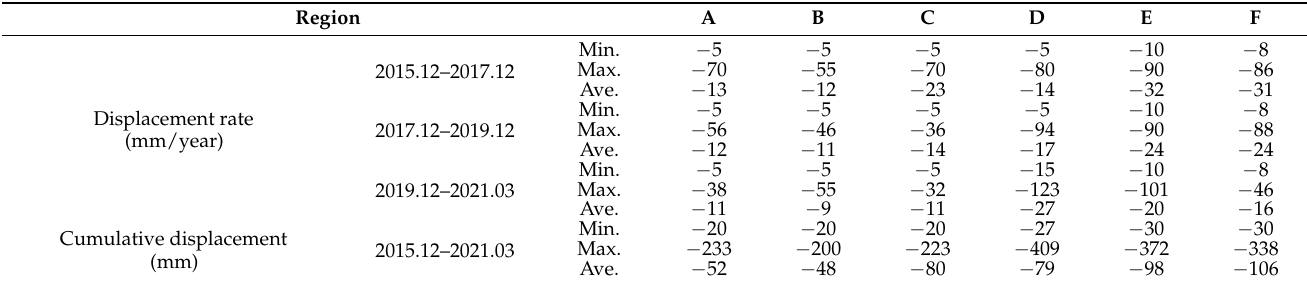
Table 2. Statistics of the surface displacement in Regions A–F, derived from ascending Sentinel-1 images. Region A B C